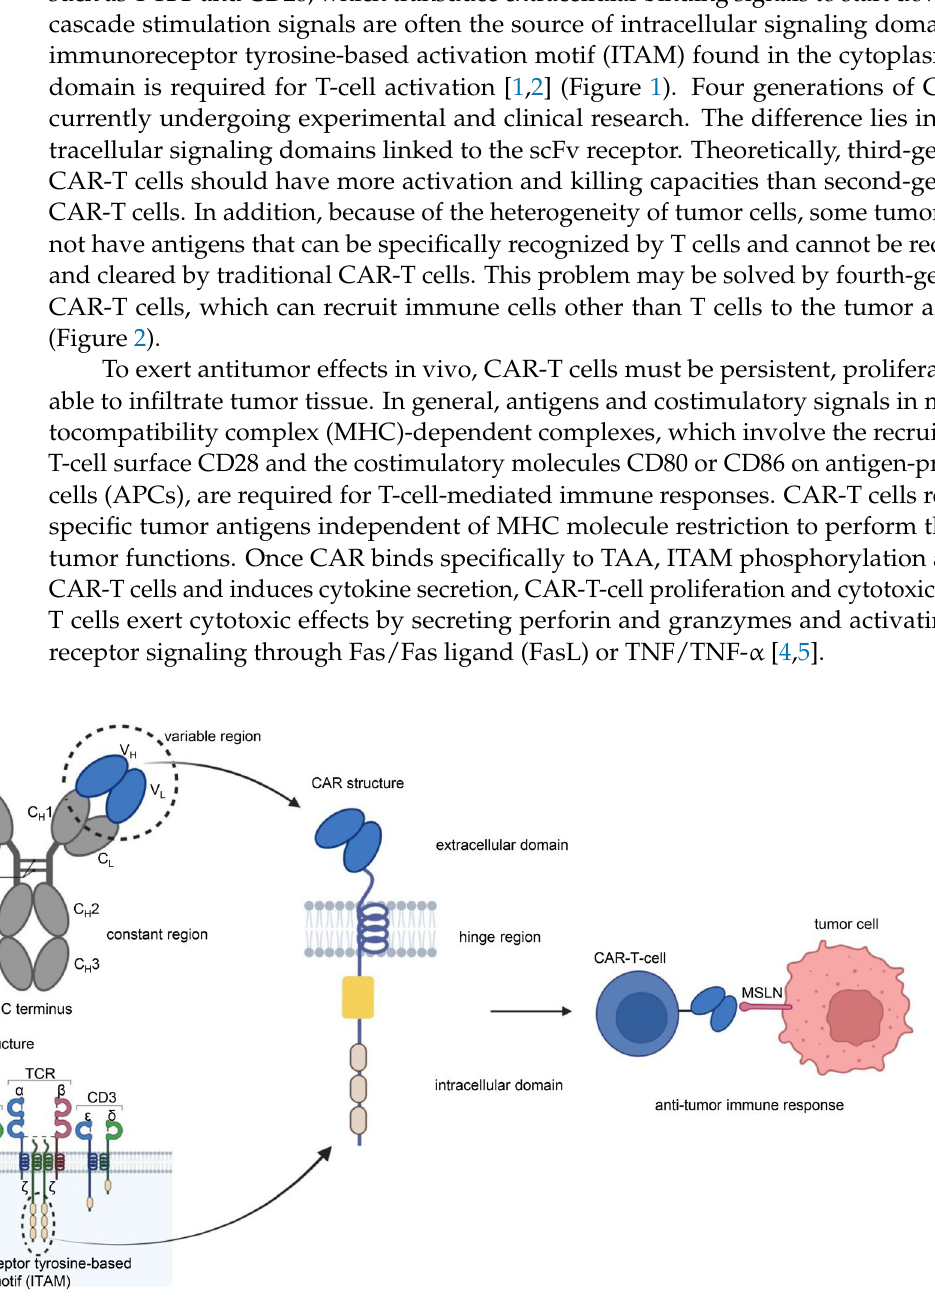
Figure 1. Chimeric antigen receptor (CAR) is a protein composed of three parts: an extracellular antigen-binding domain, an intracellular signaling domain, and a hinge region. The single-chain variable region (scFv) of the extracellular antigen-binding domain of CAR-T cells originates from the V H and V L of monoclonal antibodies. The intracellular signaling domain consists of a costimulatory factor and CD3 signal domain. The CD3 signal domain originates from the immunoreceptor tyrosine-based activation motif (ITAM) of the TCR/CD3 subunit structure. The scFv of anti-MSLN CAR-T cells binds specifically to MSLN on the surface of tumor cells to induce an antitumor immune response. Illustration was created with Biorender.com.